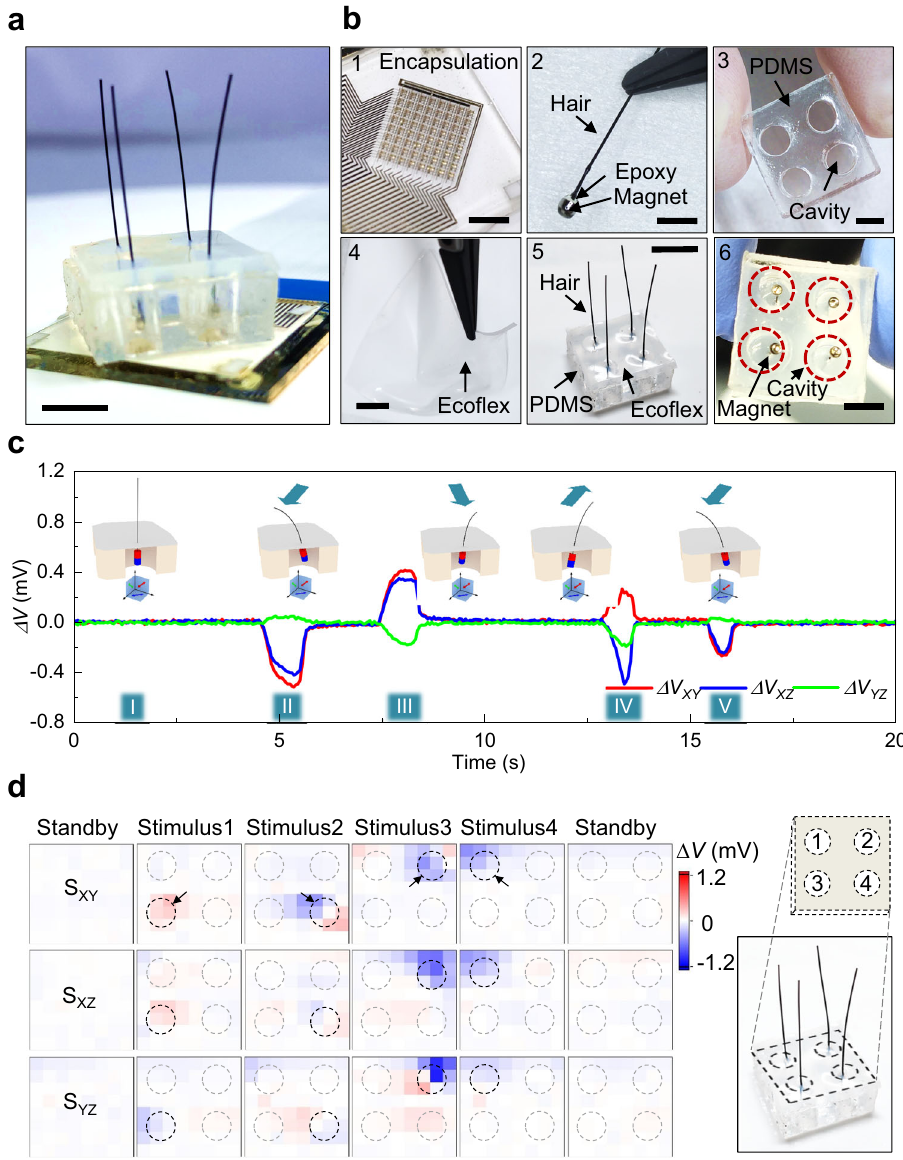
Fig. 4 Magnetic hair embedded e-skin for mechanoreception. a Photograph of the magnetic hair embedded e-skin system. It consists of an encapsulated IMOS array for signal reception and a magnetic hair embedded skin layer for the transducing of mechanic stimulus Scale bar, 5 mm. b Photographs of the integration process. 1, The IMOS device is encapsulated by epoxy. Scale bar, 4 mm. 2, The small magnet is adhered to a hair and embedded in epoxy. Scale bar, 2 mm. 3, A spacer PDMS fi lm with cavities is fabricated. Scale bar, 5 mm. 4, Ultra- fl exible Eco fl ex fi lm is casted. Scale bar, 2 mm. 5, Magnetic hair, PDMS spacer and Eco fl ex skin are assembled. Scale bar, 15 mm. 6, Bottom view of the skin layer showing that the magnets are hold within the cavities of the PDMS spacer. Scale bar, 5 mm. c Single pixel response over time by bending the hair in different directions. The initial state (I) and the different bending directions (II – V) of the magnetic hair are illustrated schematically. d Response of the pixel array to the mechanical stimuli of multiple hairs. Source data are provided as a Source Data fi